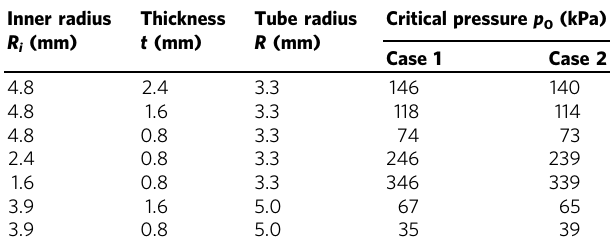
Table 3 The critical pressure simulated for different fl ask and membrane radii Inner radius R i